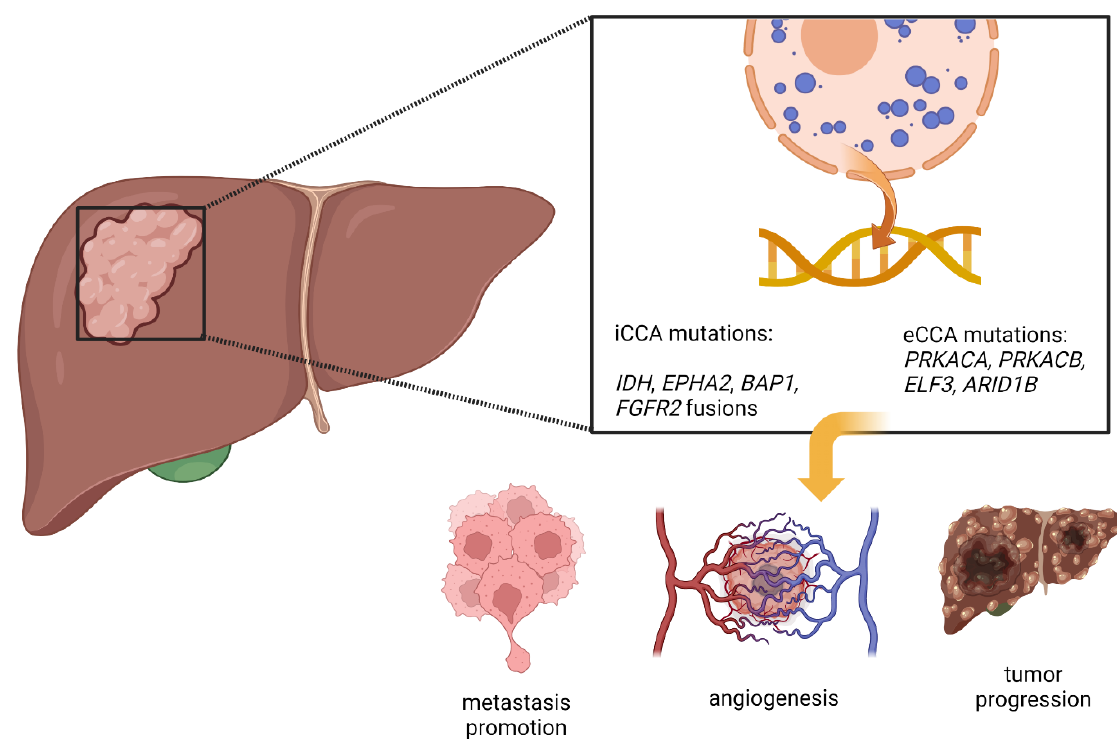
Figure 2. Mutations in CCA, both in iCCA and eCCA, and processes to which they